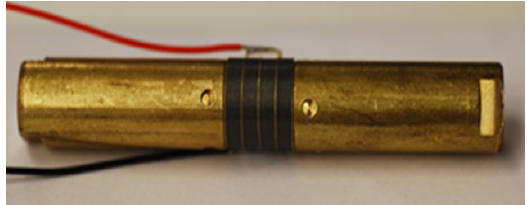
Figure 1. A typical Langevin